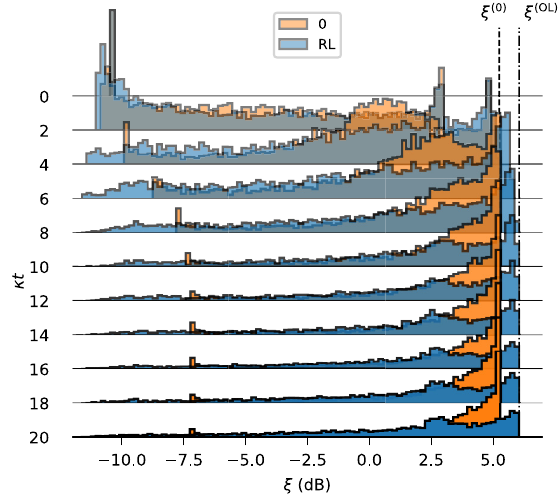
FIG. 4. Histograms of the probability density of the squeezing ξ (expressed in decibels) perpendicular to the conditional first- moment vector ¯ r c for different times and for both the no-control protocol (orange histograms) and the RL agent feedback protocol (blue histograms). The two vertical lines correspond to the two bounds on the amount of squeezing for the no-control protocol ξ ( 0 ) and for the open-loop control protocol ξ ( OL ) . The results are obtained by simulating N = 5000 trajectories with time step dt = 0.001 /κ , by fixing the other parameters as ω = 0.1, χ = 0.49 κ , and η = 0.9, and by considering as an initial state a thermal state with n th = 5 and initial first-moment vector ¯ r c ( 0 ) = ( 0, 0 ) .